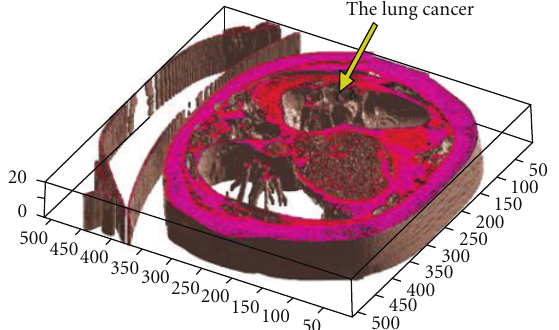
Figure 24: Segmenting patient volume data a ff ected by the lung cancer.